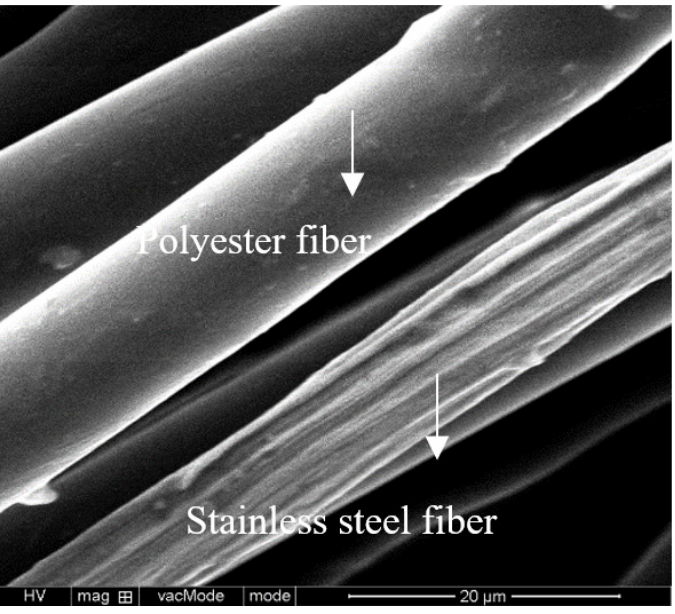
Figure 1. Stainless steel fiber and polyester fiber.